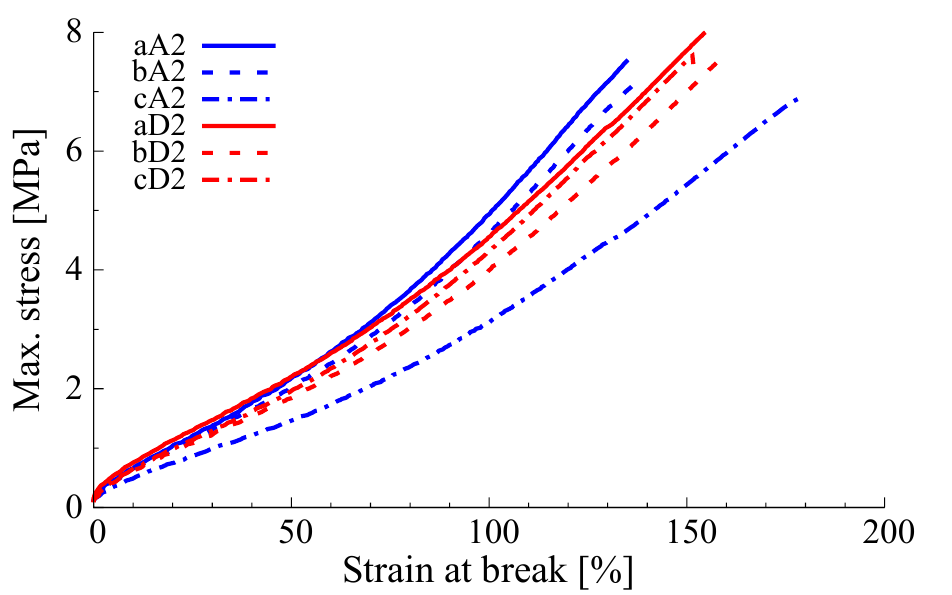
Figure 11. Stress-strain diagram of the three samples with highest tensile strength for screw configu- rations A and D. See Tables 3 and